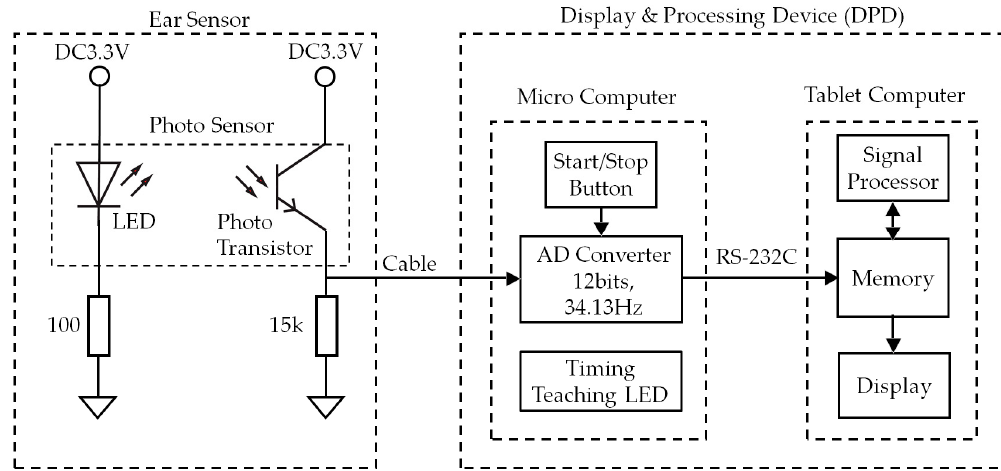
Figure 2. Block diagram of the earable POCER. The photo sensor is equipped with one light-emitting diode (LED) with a wavelength of 940 nm and one photo transistor. The DPD is comprised of an AD converter, start/stop button, timing teaching LED, signal processor, memory, and display. The analog signal measured with the ear sensor is converted into a digital signal with a sampling frequency of 34.13 Hz using the AD converter. The measured values, converted into a digital signal, are recorded in the memory. Based on the information recorded in memory, the respiratory frequency is calculated from the signal processor, and the respiratory frequency and frequency waveform are shown on the display. The timing instruction LED has a duty ratio of 50%, and frequencies with the three patterns of 200 mHz, 267 mHz, and 333 mHz. The start/stop button is used for starting and stopping the earable POCER.